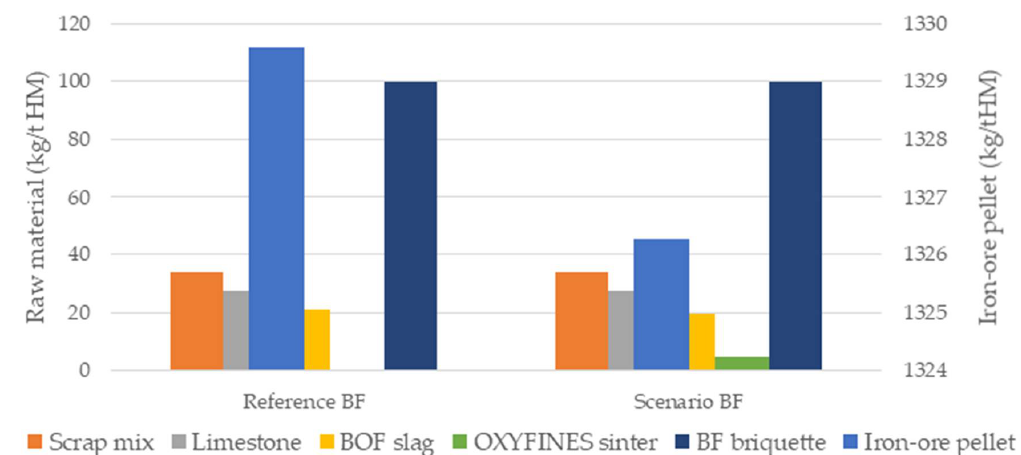
Figure 2. Results on charged BF raw materials (kg / tHM) from using the OXYFINES sinter.